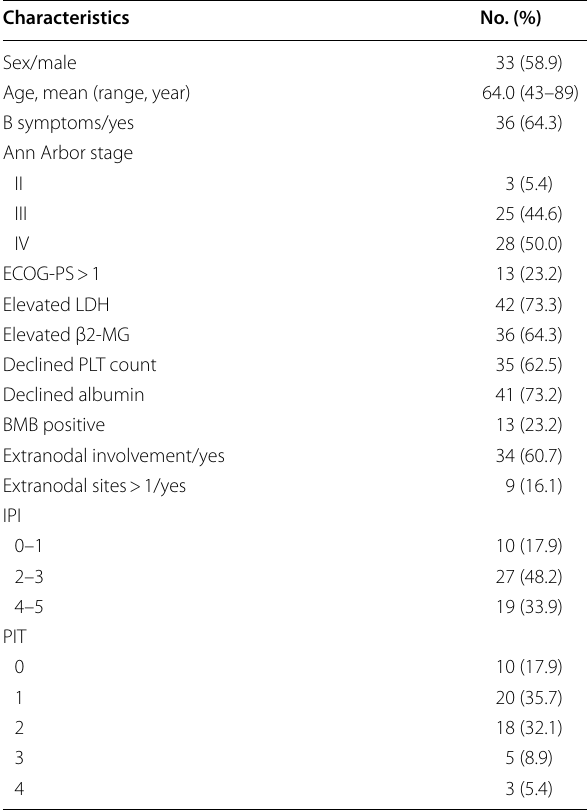
ECOG-PS, Eastern Cooperative Oncology Group Performance Status; LDH, lactate dehydrogenase; β2-MG, β2-microglobulin; PLT, platelet; BMB, bone marrow biopsy; IPI, international prognostic index; PIT, prognostic index for T-cell